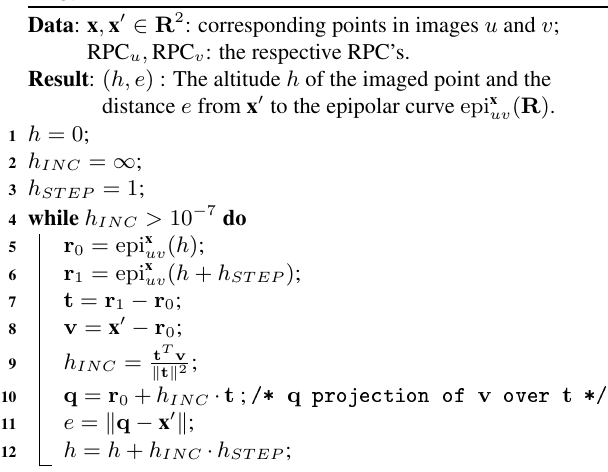
Figure 10: Illustration of one iteration of Algorithm 2. The im- ages u and v , two corresponding point x and x 0 , and the epipolar ( R ) . curve epi x uv Algorithm 2: Altitude of a point from a correspondence using RPC.